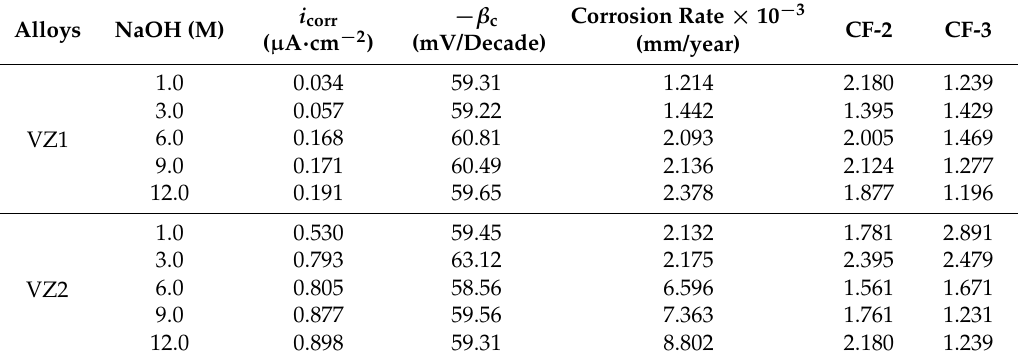
Table 3. The corrosion kinetic parameters obtained from EFM (electrochemical frequency modulation) technique for the VZ1 and VZ2 alloys as a function of NaOH concentration at 27 ◦ C.